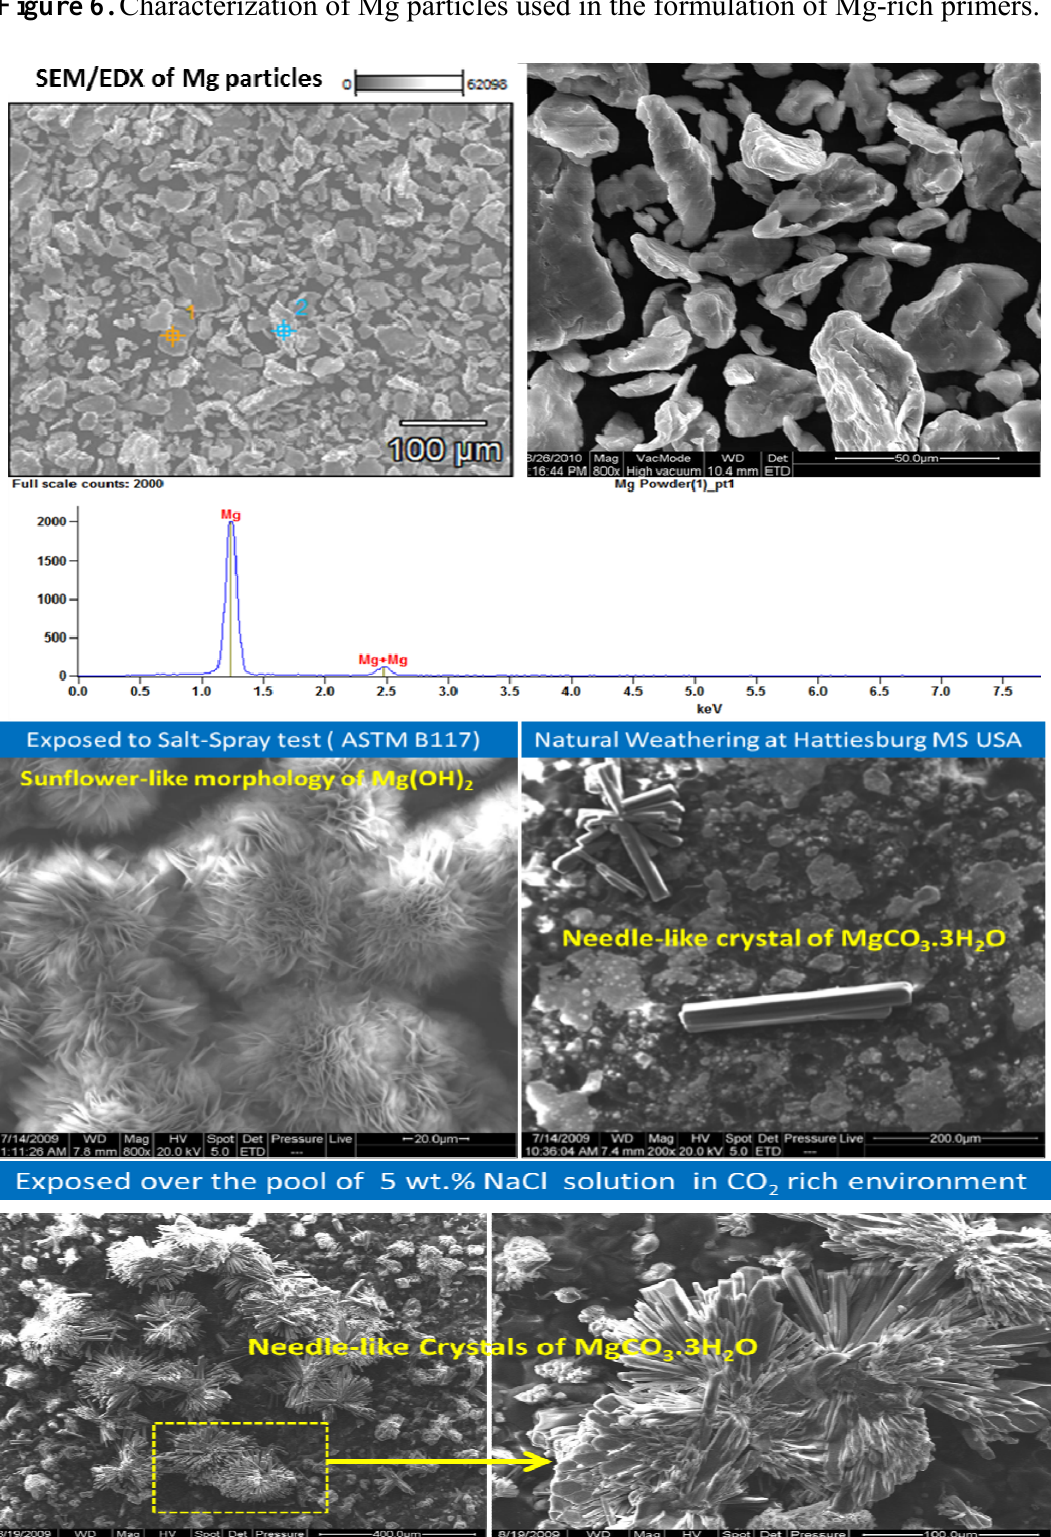
Figure 6. Characterization of Mg particles used in the formulation of Mg-rich